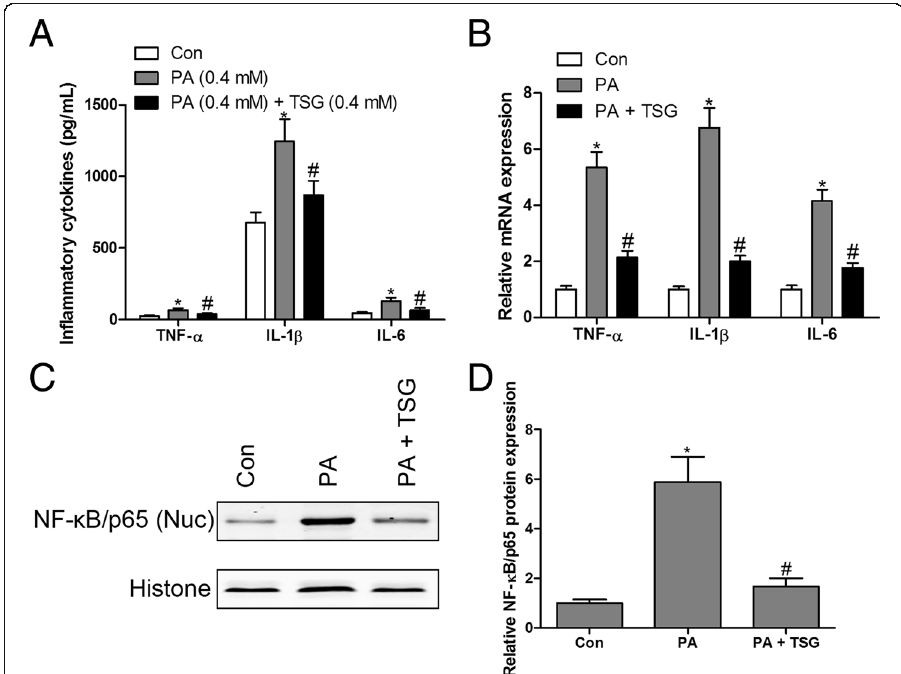
Fig. 2 TSG inhibited PA-induced inflammation in H9c2 cardiomyocytes. PA-stimulated H9c2 cells with or without TSG (0.4mM) for 48h, TNF- α , IL-1 β and IL-6 levels in the supernatant were measured by ELISA kit ( a ); RT-qPCR was performed to measure the mRNA expression of TNF- α , IL-1 β and IL-6 ( b ); protein expression of NF- κ B/p65 in the nucleus was measured by western blotting ( c and d ). * P <0.05 compared with control group; # P <0.05 compared with PA group. n =3 in each